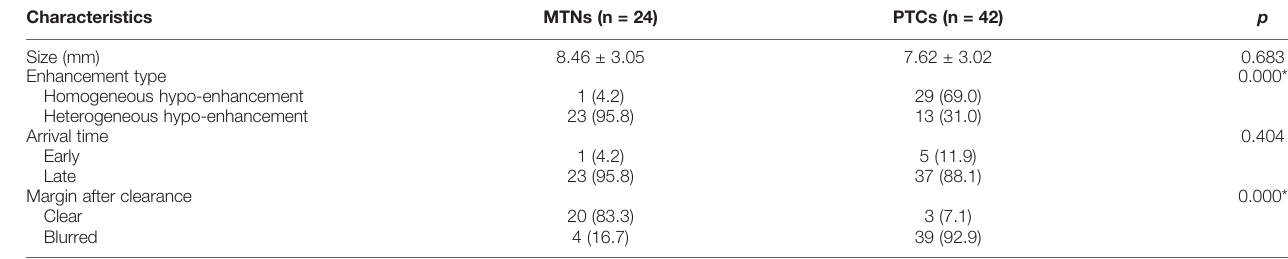
TABLE 2 | CEUS Characteristics of the B pattern MTNs and